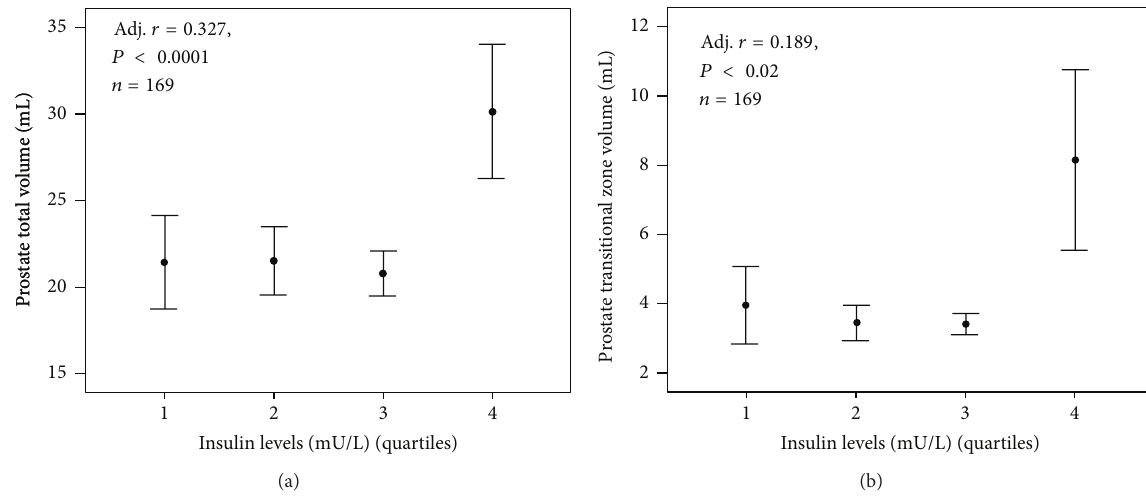
Figure 1: Association between insulin levels and prostate total or transitional zone volume. Association between insulin levels and prostate total (a) or transitional zone (b) volume. Insulin levels are reported as quartiles. All data are adjusted for age and total testosterone. Data are derived from a series of subjects seeking medical care for coupler infertility at our unit. The number of subjects with available parameters is reported in the inset. Note that the statistical analyses have been performed using insulin levels as a continuous variable, even if grouped in quartiles for graphical